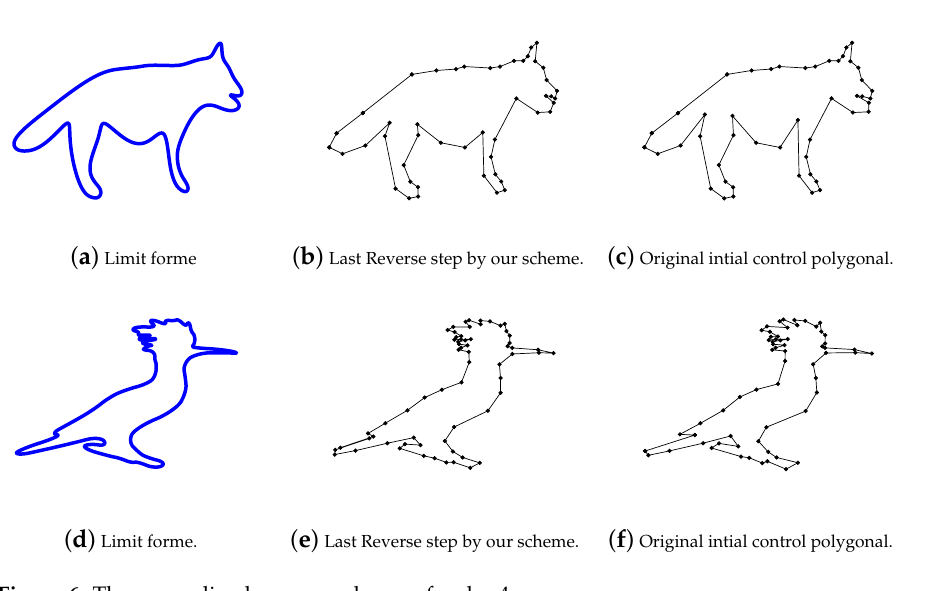
Figure 6. The generalized reverse scheme of order